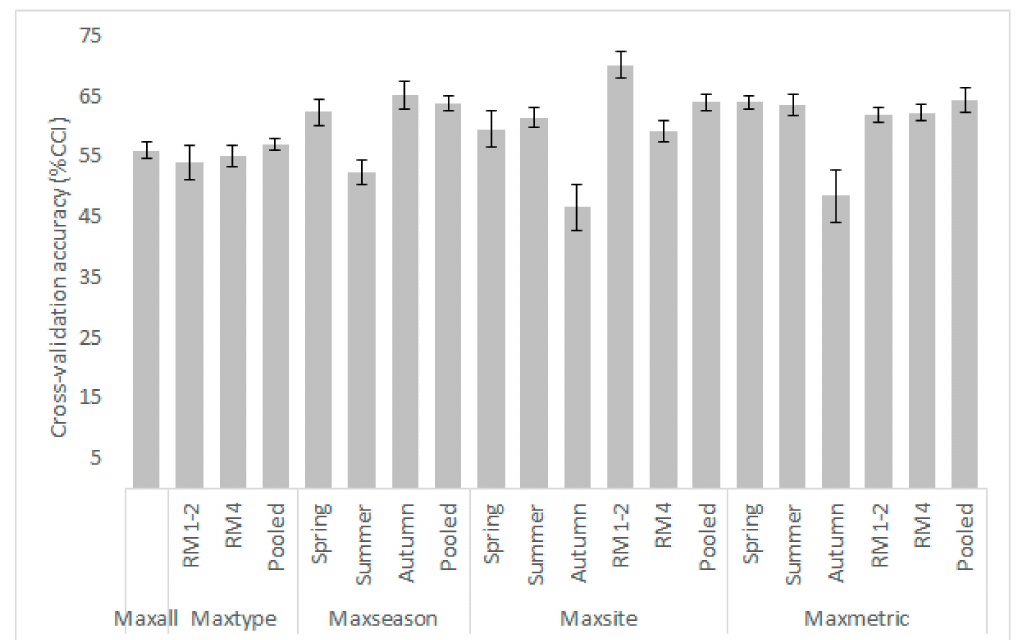
Figure A7. Mean (gray shaded columns) and standard deviation values from the 10-fold cross validation process for each κ -normalization alternative (model) applied for the Oinoi reach. CCI: Correctly Classified